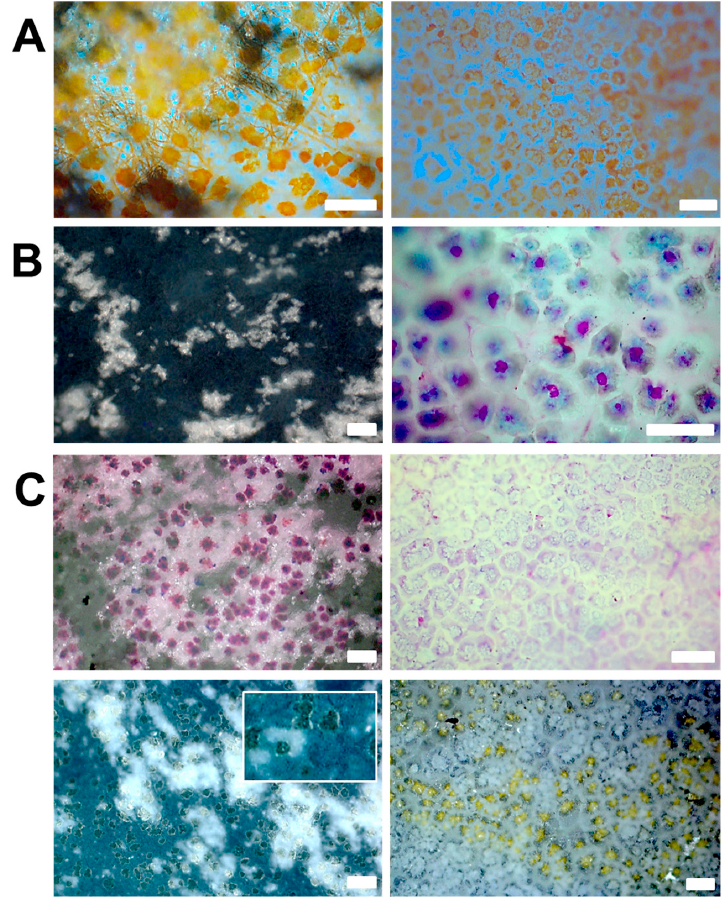
Figure 2. Representative images of outer egg membrane ( left panel) and inner shell ( right panel) surfaces stained using ( A ) Congo red, ( B ) 1,9-dimethyl-methylene blue (DMMB) and ( C ) Stains-all. Scale bars represent 50 μ m ( left panel) and 100 μ m ( right panel).